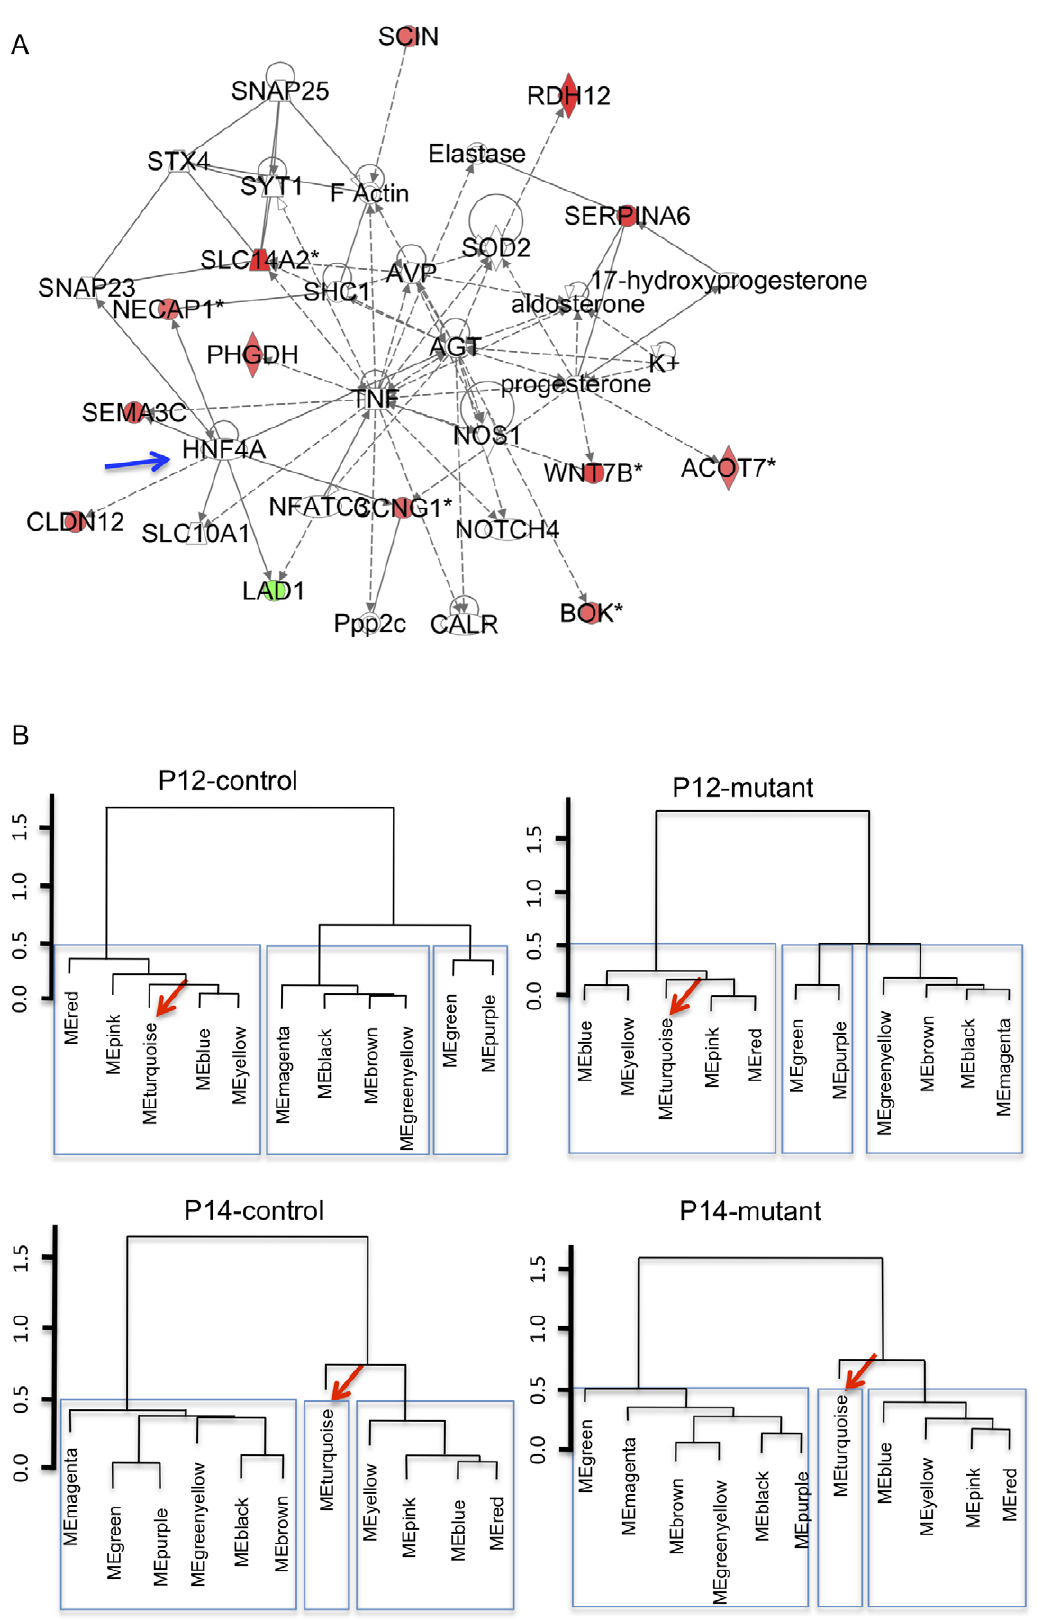
Figure 2. Metabolic pathways could underlie kidney maturation and determine the susceptibility to rapid cyst formation in the early-onset model of ADPKD. A) Knowledge-based IPA network (score: 24) using genes in early-onset mutant-signature (genes in Table S1). HNF4 a (blue arrow) is a node (green/red: genes down/up-regulated in P12 mutant kidneys; solid lines: direct interactions; dashed lines: indirect PLOS Genetics | www.plosgenetics.org